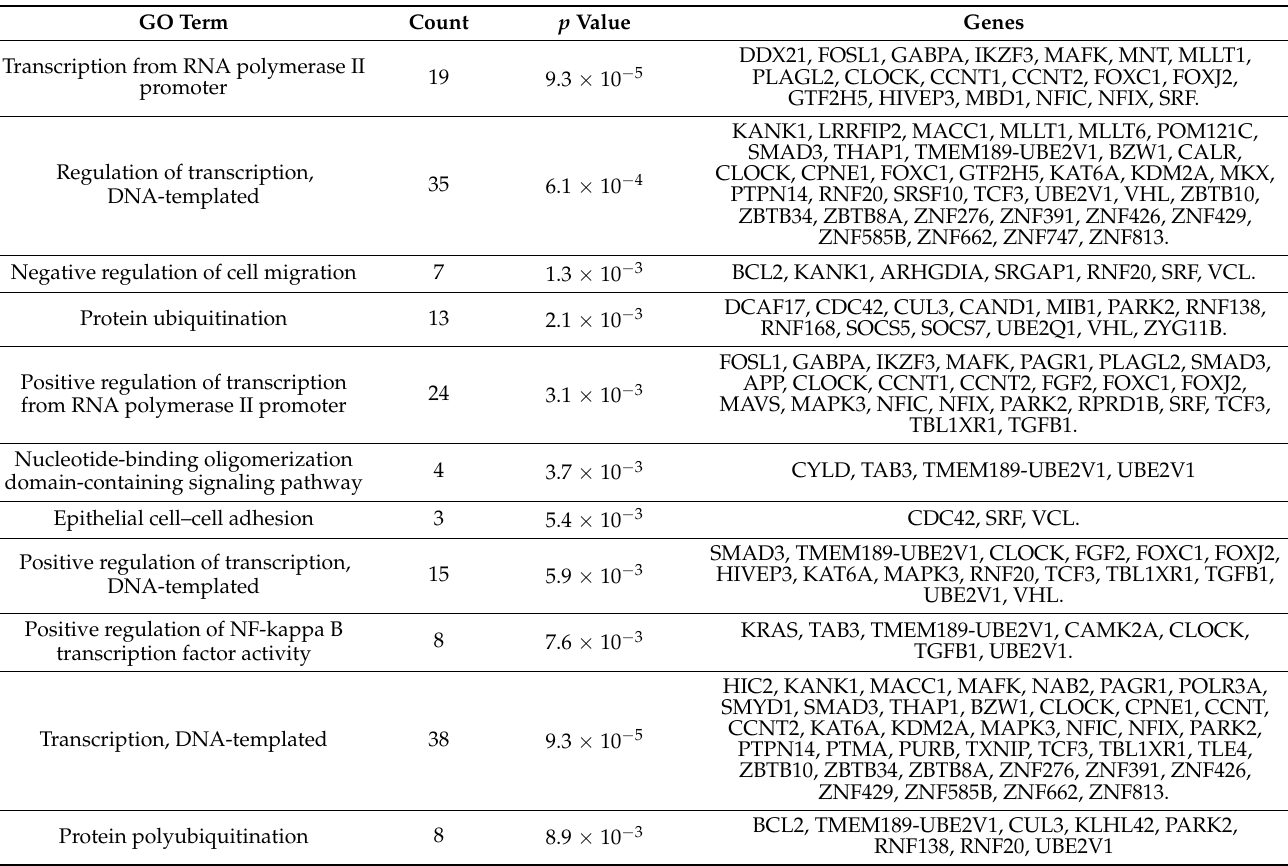
Table 2. Biological processes enriched in target genes.